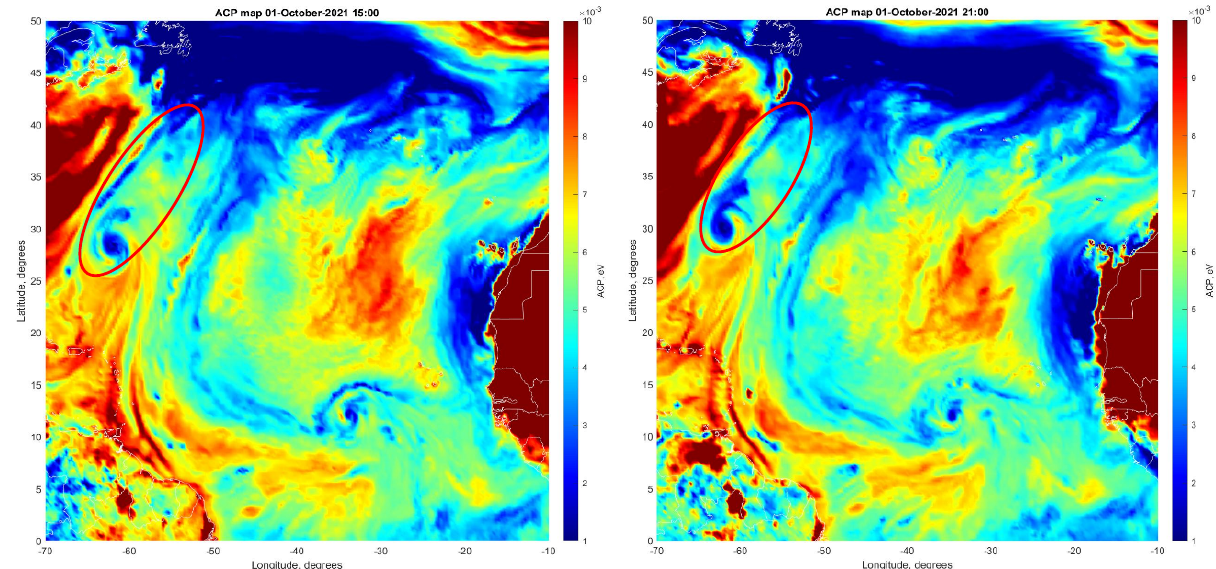
Figure 3. Left panel—Hurricane Sam’s position on 1 October 2021 at 15:00 UTC; right panel—Hurricane Sam’s position on 1 October at 21:00 UTC.